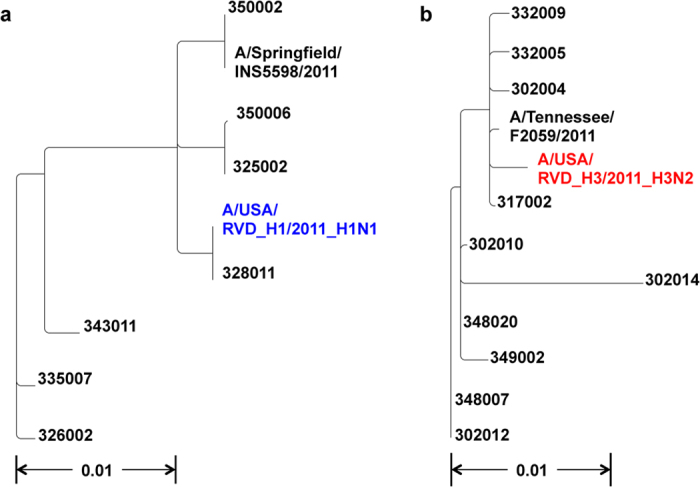
Phylogenetic trees comparing H1N1 and H3N2 clinical samples to known sequences.Phylogenies demonstrate the variation in sequence across the (a) H1N1 and (b) H3N2 clinical sample compared to the amplicon HA control sample sequences (A/USA/RVD_H1/2011_H1N1 and A/USA/RVD_H3/2011_H3N2) and the closest independent sequence isolate by BLAST search (A/Springfield/INS5598/2011 and A/Tennessee/F2059/2011). The scale bar indicates number of substitutions per nucleotide. Phylogenies were created using phylogenetic tree tools available at fludb.org.